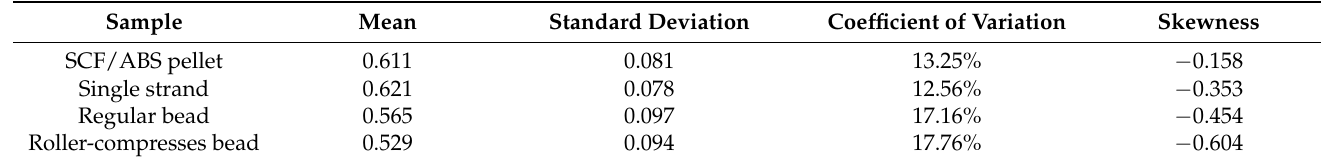
Table 7. Mean, standard deviation, coefficient of variation and skewness of void sphericity in four scanned parts.